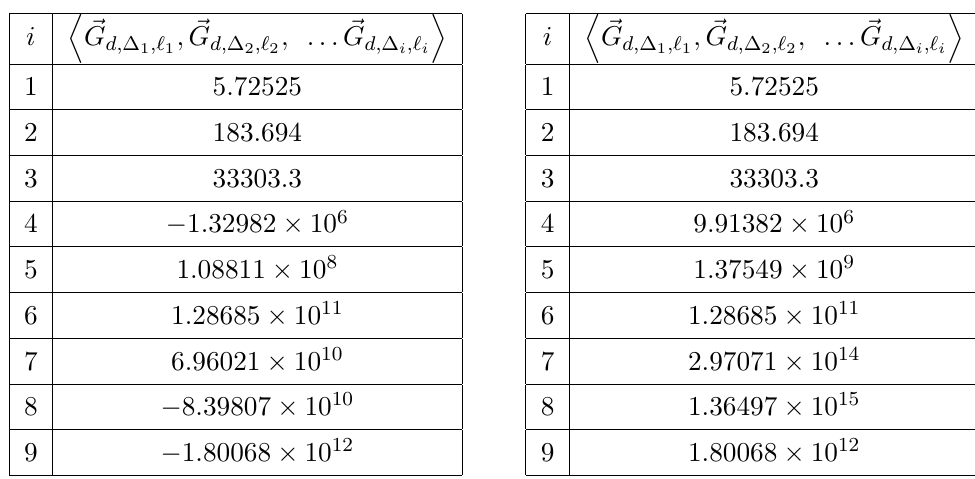
Table 7. Left: determinants of (cid:12)rst few operators of 2D Ising model using equation (2.1), spec- trum (B.1) in increasing order of (cid:1) (cid:0) ‘ , here we have ordered the degenerate ordering in increasing ordering of (cid:1) and Right: determinants of (cid:12)rst few operators of 2D Ising model using (2.1), spec- trum (B.1) in increasing order of (cid:1) (cid:0) ‘ using spectrum (1) of eq.